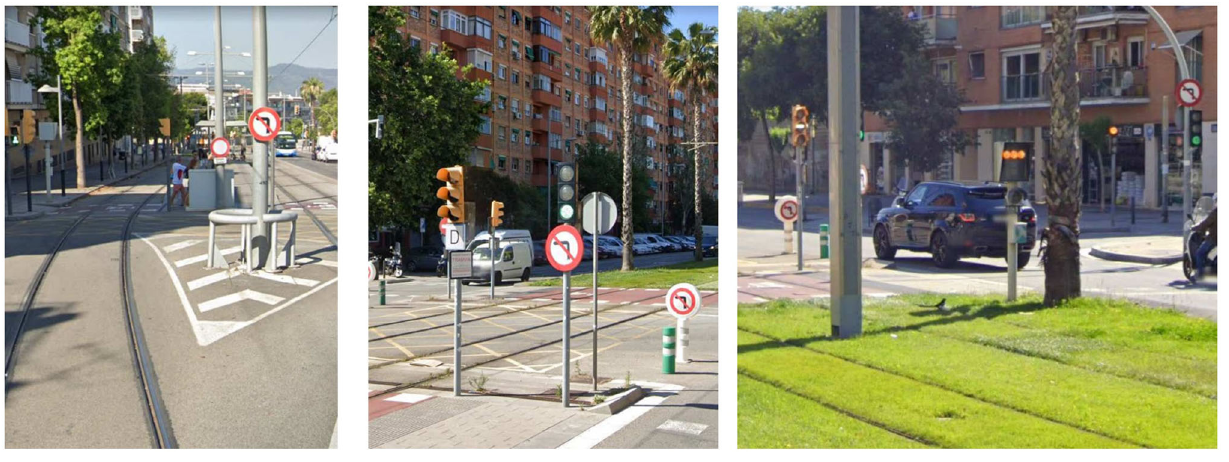
Fig. 6 Vertical no-turn signs. Trams in Barcelona and Valencia - source from Google Earth (data provider: (cid:2) 2020 Google)